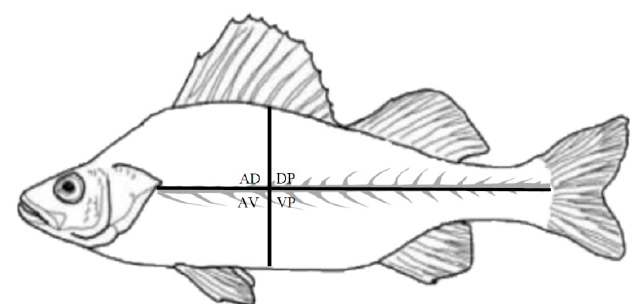
Figure 1. Lake Iseo (Lombardy, Northern Italy) and location of sampling sites (in red). A: Costa Volpino (northern area, 45°49’01.2” N 10°05’18.1” E); B: Pisogne (northern area, 45°48’26.8” N 10°04’23.0” E); C: Carzano (central area, 45°42’48.3” N 10°05’48.5” E); D: Clusane (southern area, 45°39’45.3” N 10°00’46.2” E).